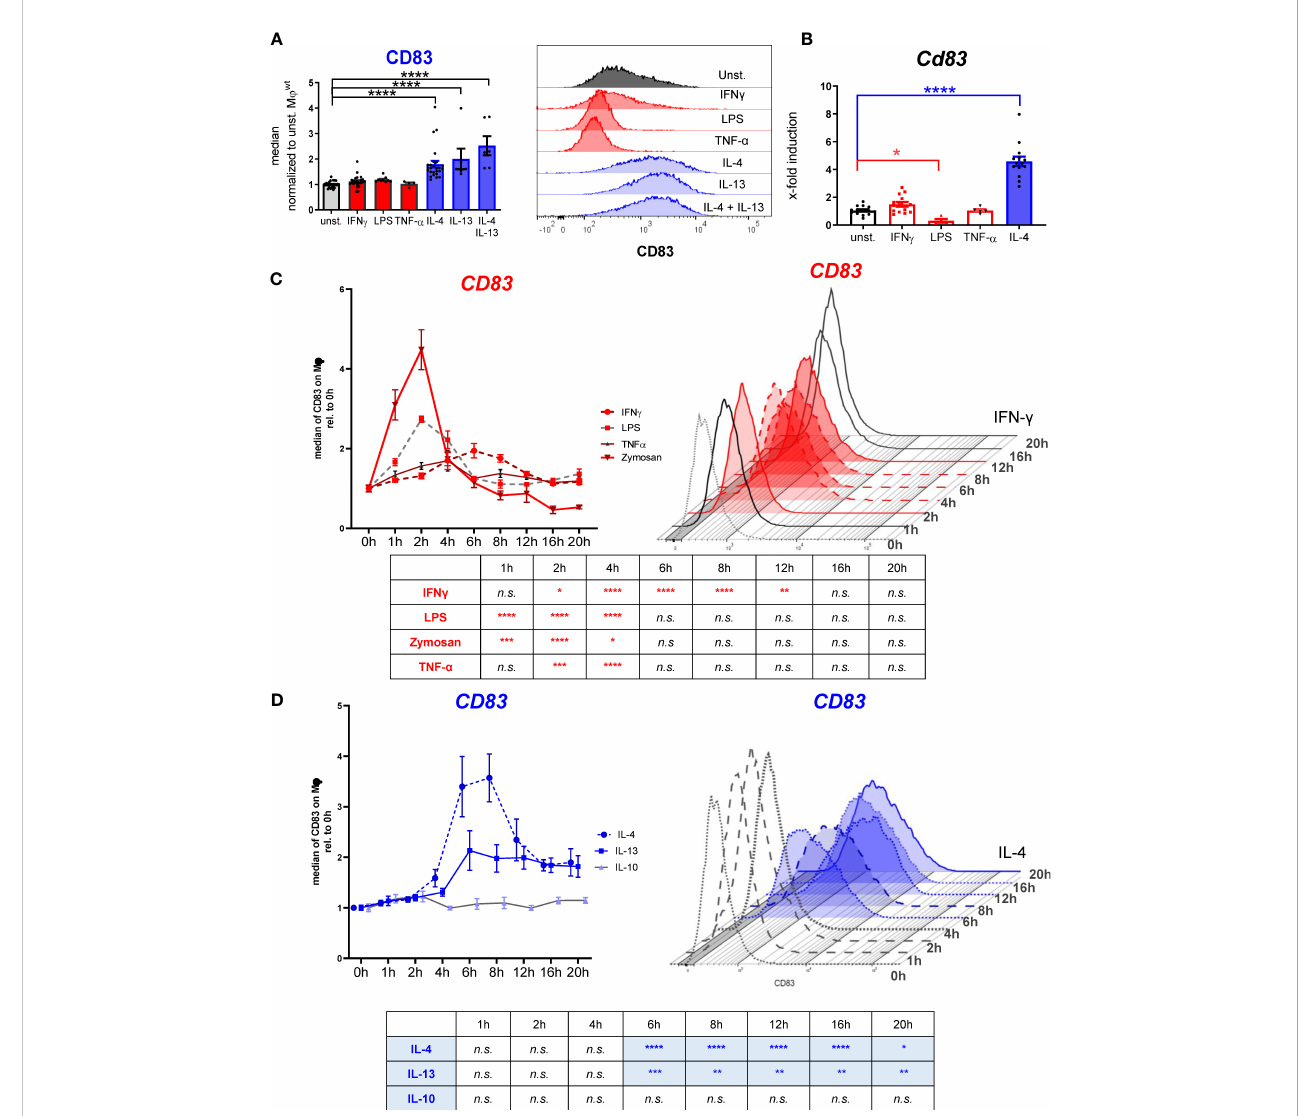
FIGURE 1 Analyses of CD83 surface expression by murine bone-marrow derived M j using different stimuli. Murine bone-marrow derived macrophages were generated and CD83 expression levels were analyzed after in fl ammatory or alternative activation. (A) Flow cytometric analyses show no CD83 expression on murine M j upon stimulation with IFN- ɣ (300 U/ml), LPS (100ng/ml), TNF- a (300 U/ml) for 16h. In contrast, stimulation with IL-4 (40 ng/ml), IL-13 (40 ng/ml) or IL4+IL-13 resulted in high CD83 expression on the surface of M j at the 16h time point (n ≥ 4) (left bar graph); Representative FACS histograms are presented (right graph). (B) qPCR analyses of Cd83 mRNA expression after different stimulations in murine M j . (C) Time-dependent regulation of CD83 expression on BMDM after in fl ammatory activation with IFN- ɣ (300 U/ml), LPS (100ng/ml), TNF- a (1000 U/ml) or Zymosan 10 µg/ml (n ≥ 4), analyzed by fl ow cytometry. (D) Time- dependent regulation of CD83 expression on BMDM upon stimulation with IL-4 (40 ng/ml), IL-13 (40 ng/ml) or IL-10 (10 ng/ml) (n ≥ 4), analyzed by fl ow cytometry. Gating strategy for the M j population is depicted in Supplementary Figure 2. Data are represented as mean ± SEM. Statistical analysis was